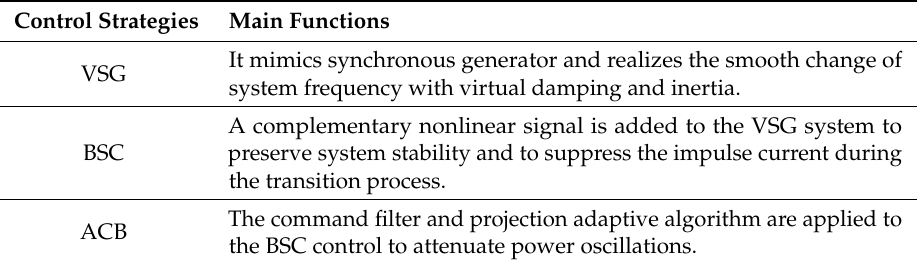
Table 1. Comparison of Several Control